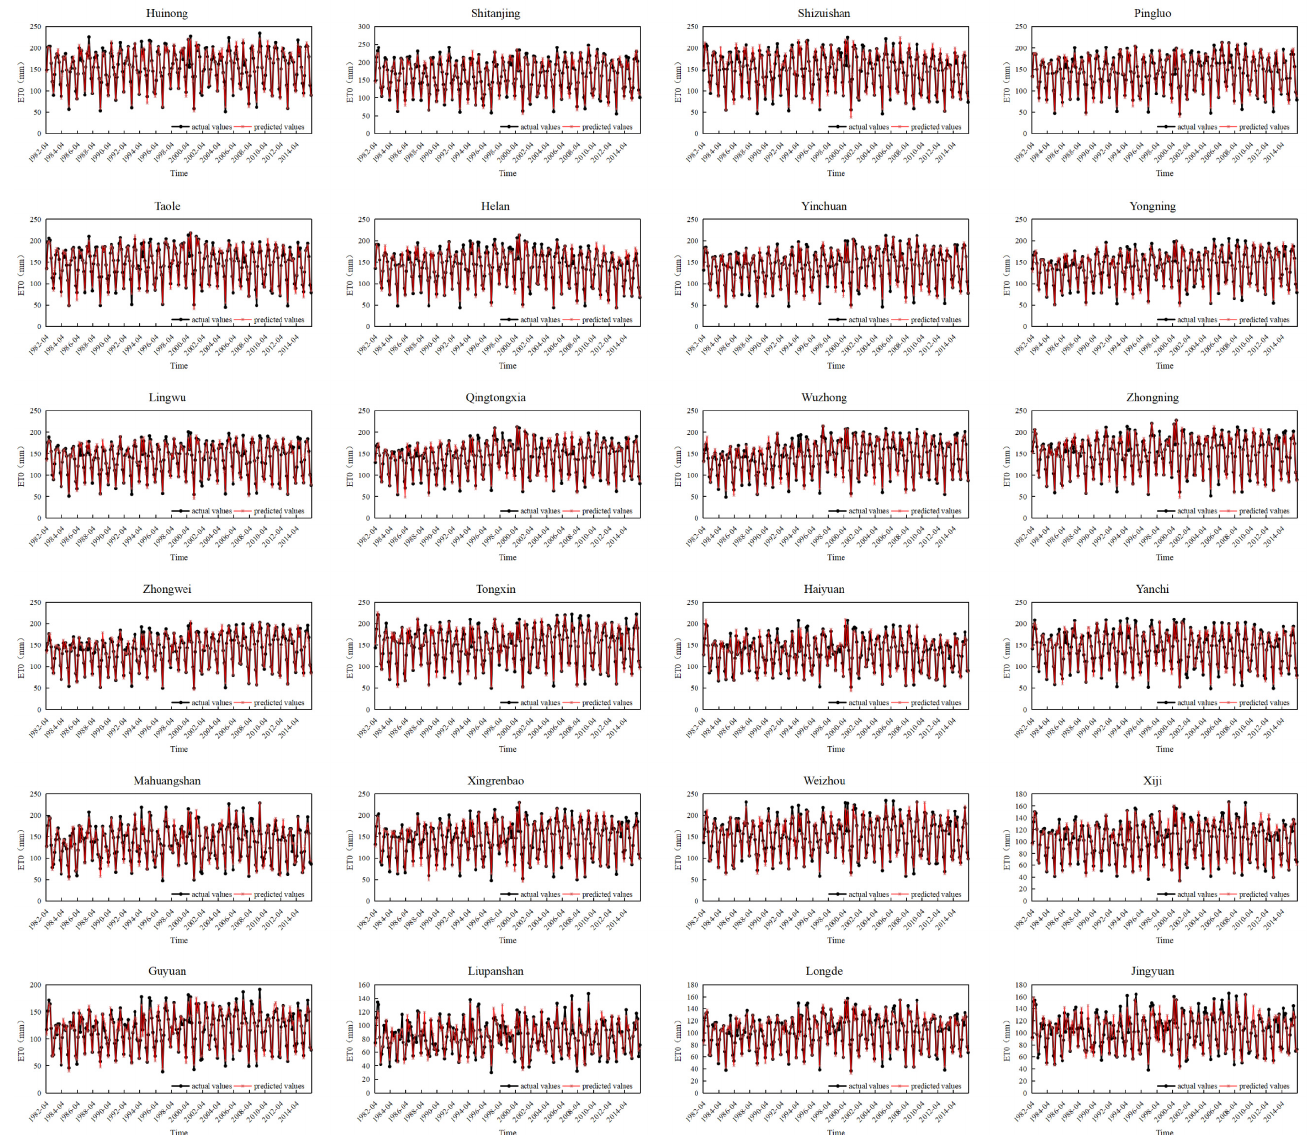
Figure 9. The Ningxia area fitted with back-generation .